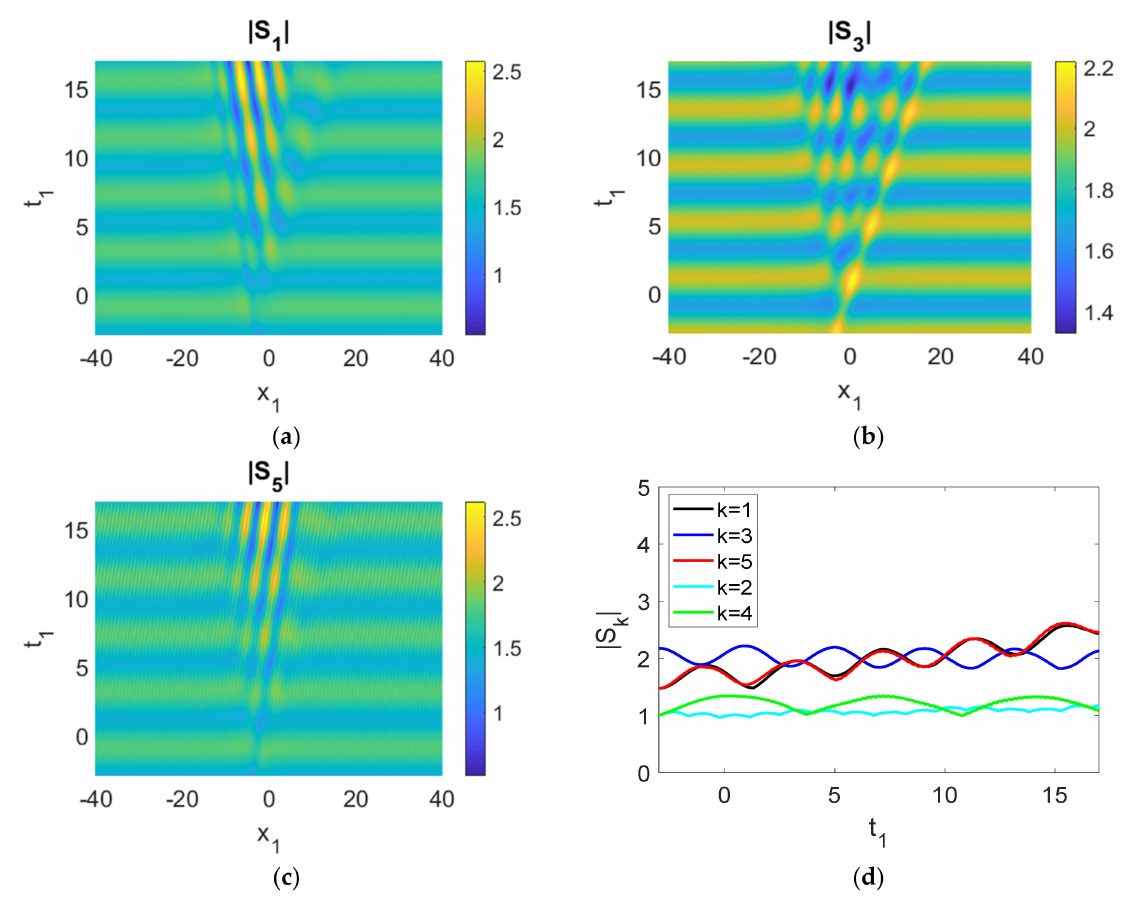
Figure 9. ( a – c ) Evolution of the wave components; ( d ) time history of the moduli of the envelopes, | S k |. Parameters used were c g 1 = − 0.5, c g 3 = 1, c g 5 = 0.5, c g 2 = − 0.1, c g 4 = 0.6, γ 1 = 0.1, γ 3 = − 0.1, γ 5 a = 0.1, γ 2 = − 0.1, γ 4 = 0.1, γ 5 b = − 0.01, r 1 = 1, r 2 = 1, r 3 = 0, q = 1, a 2 = 1, ρ 1 = ρ 2 = ρ 3 = ρ 4 = ρ 5 =